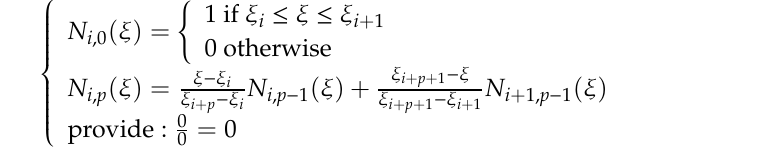
6 of 19 Figure 4. The outline of B-spline FCM: ( a ) cells in W and finite cell classification; ( b ) parametric grid;